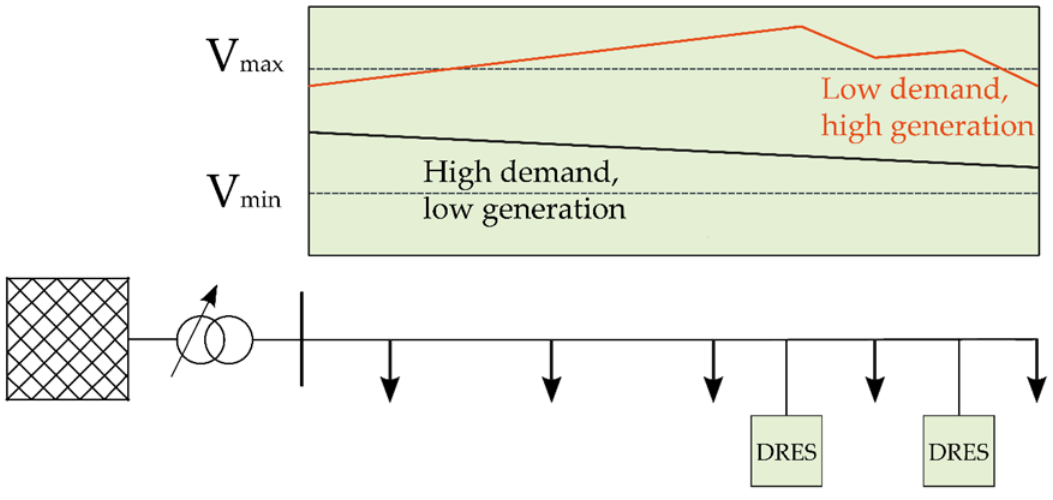
Figure 3. Voltage profile in active distribution networks.